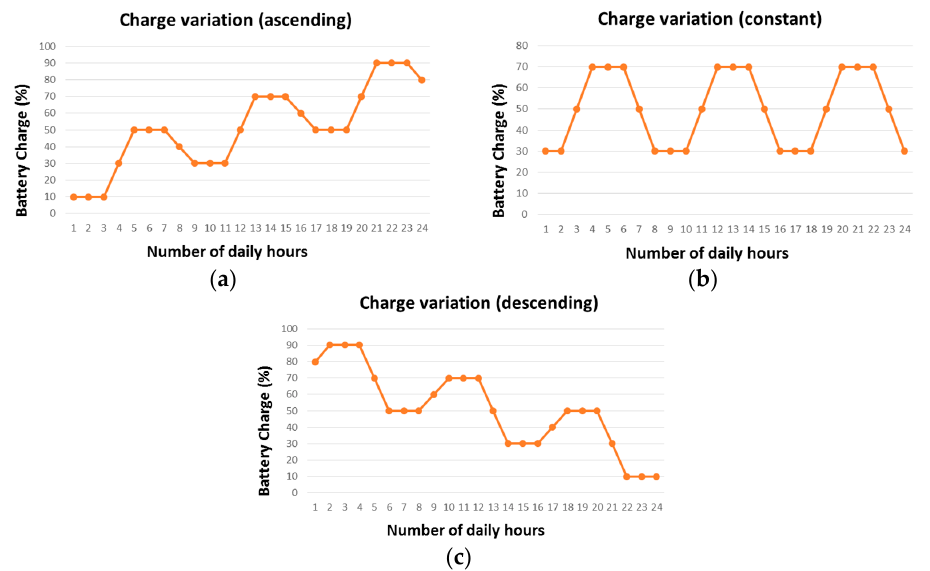
Figure 3. Graphical representation three possible algorithm strategies: ascending ( a ), constant ( b ) and descending ( c ).